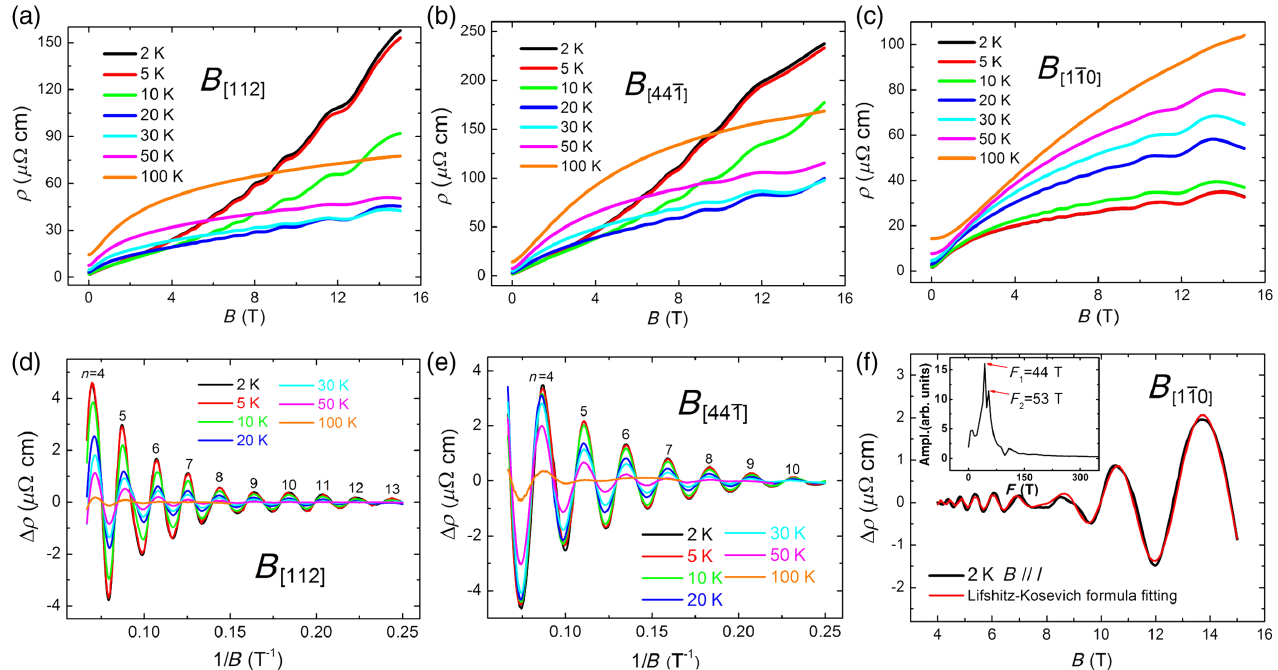
44¯ 1 (cid:2) 1¯ 1 0 (cid:2) , and ½